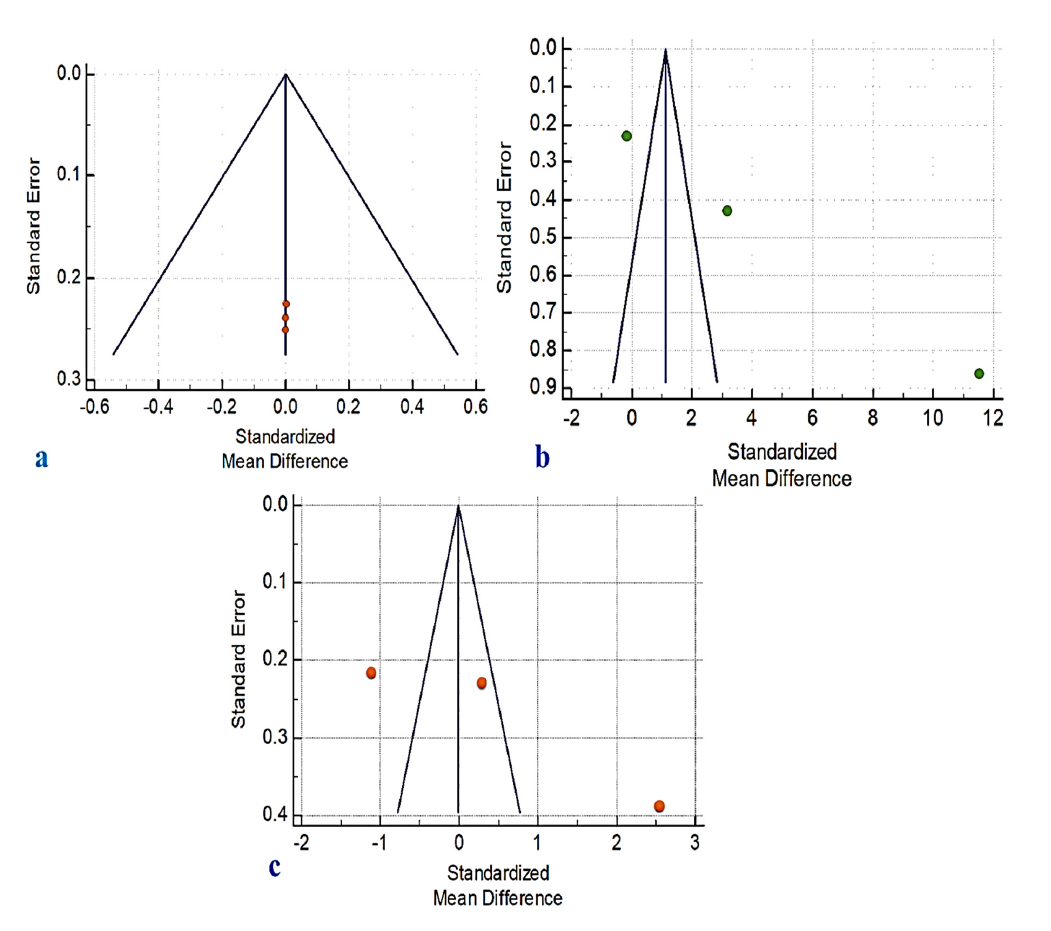
Figure 7. Funnel plot for publication bias in ( a ) DMFT, ( b ) pocket depth, and ( c ) bleeding on prob- ing. Table 2. Methodological quality assessment of the studies by Newcastle–Ottawa Quality Assess- ment Scale (NOS).